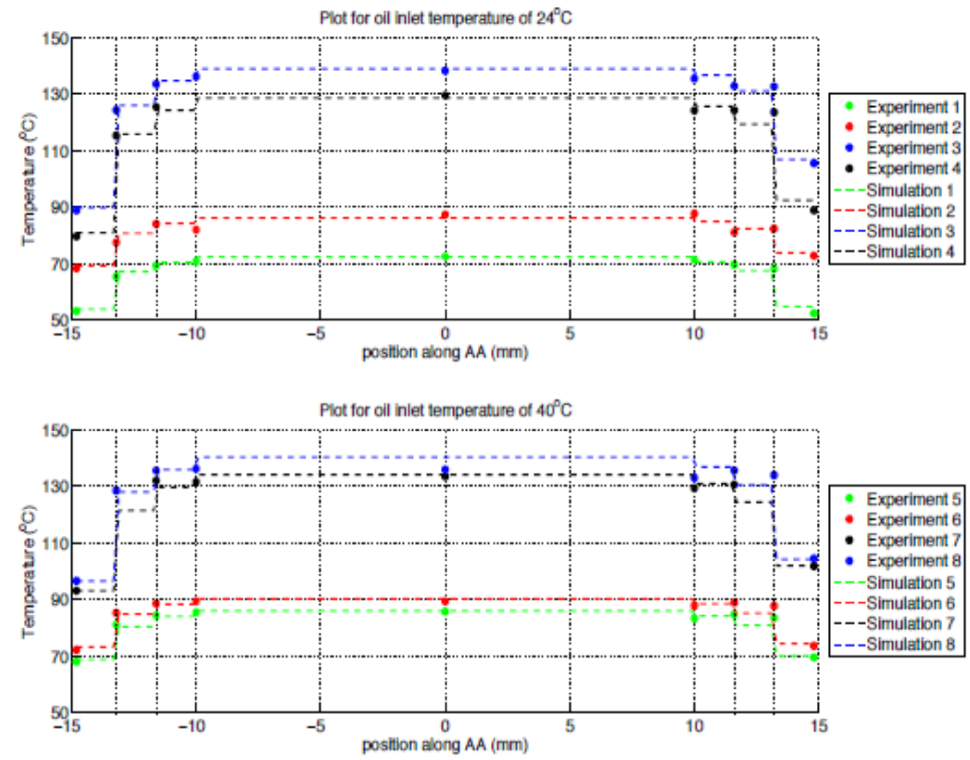
Figure 17. Comparison of the modelled and measured temperature profiles for a traditional pole piece under steady state conditions . piece under steady state